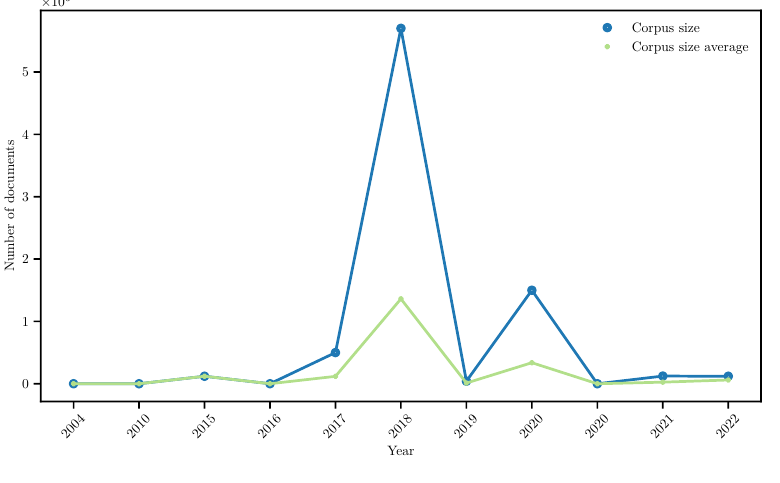
Figure 2. Corpus size